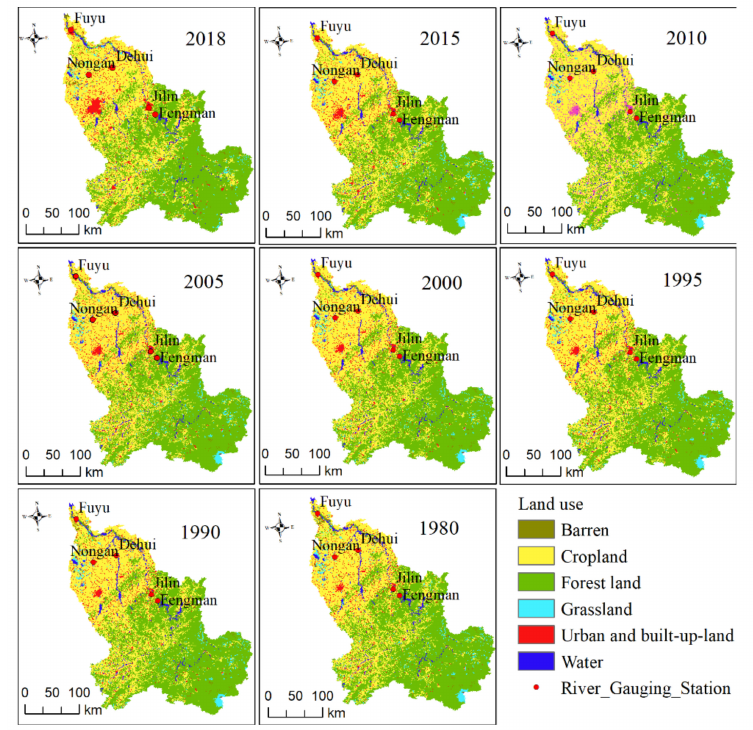
Figure 4. Spatial distribution of land use in the study area in